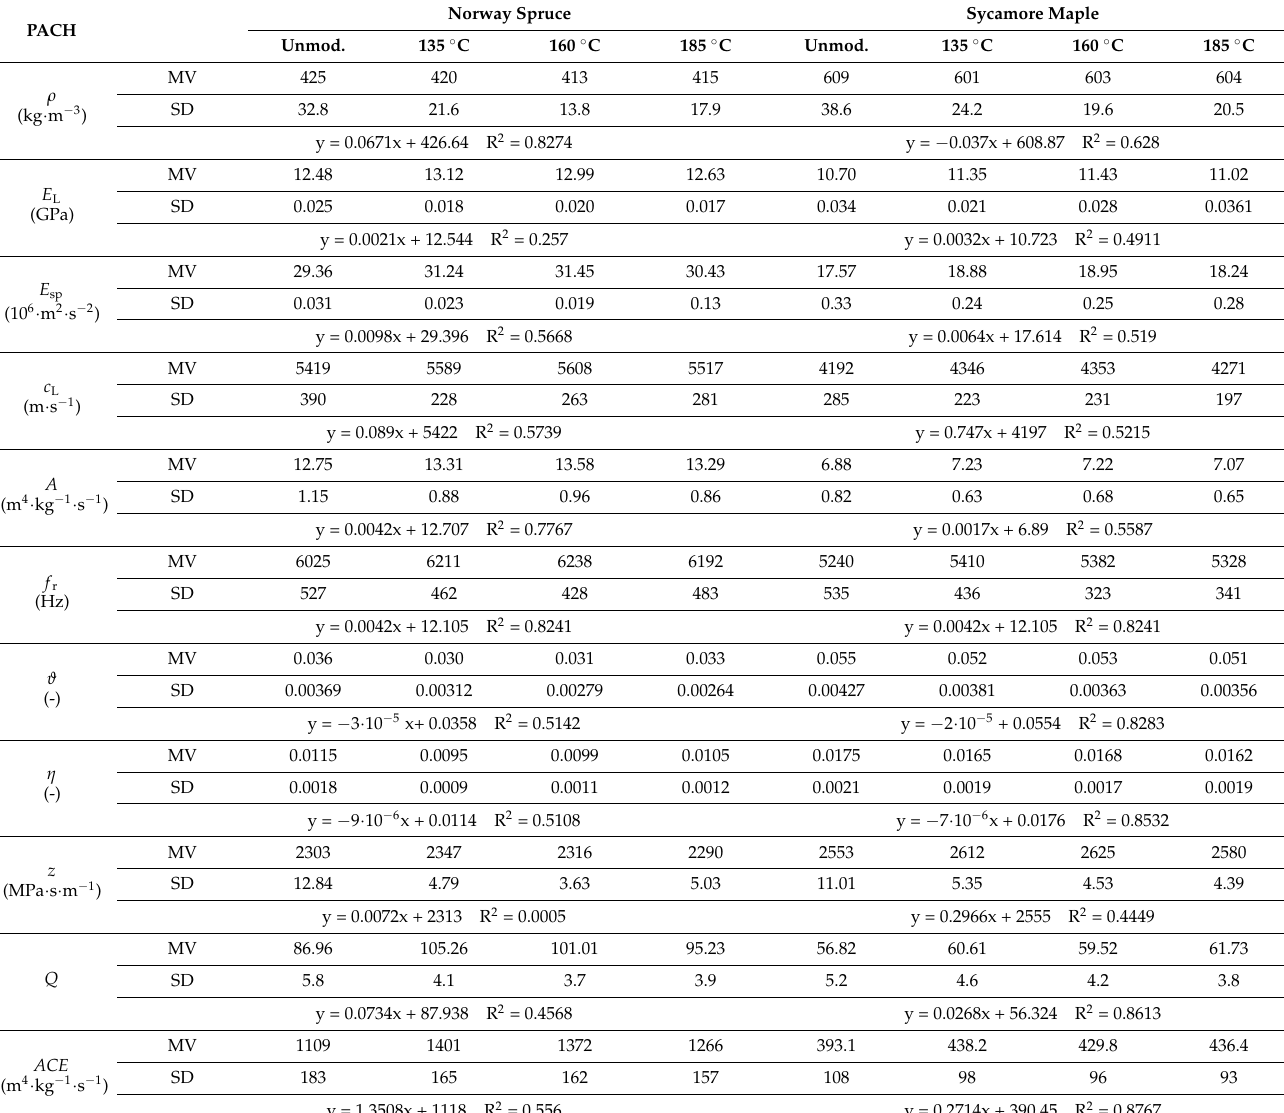
Table 1. PACH (density ρ , dynamic modulus of elasticity E L , acoustic constant A , speed of sound c L , resonant frequency f r, logarithmic damping decrement ϑ , loss coefficient η , characteristic acoustic impedance z , acoustic conversion efficiency ( ACE ) and sound quality factor Q) of spruce and maple wood before and after thermal